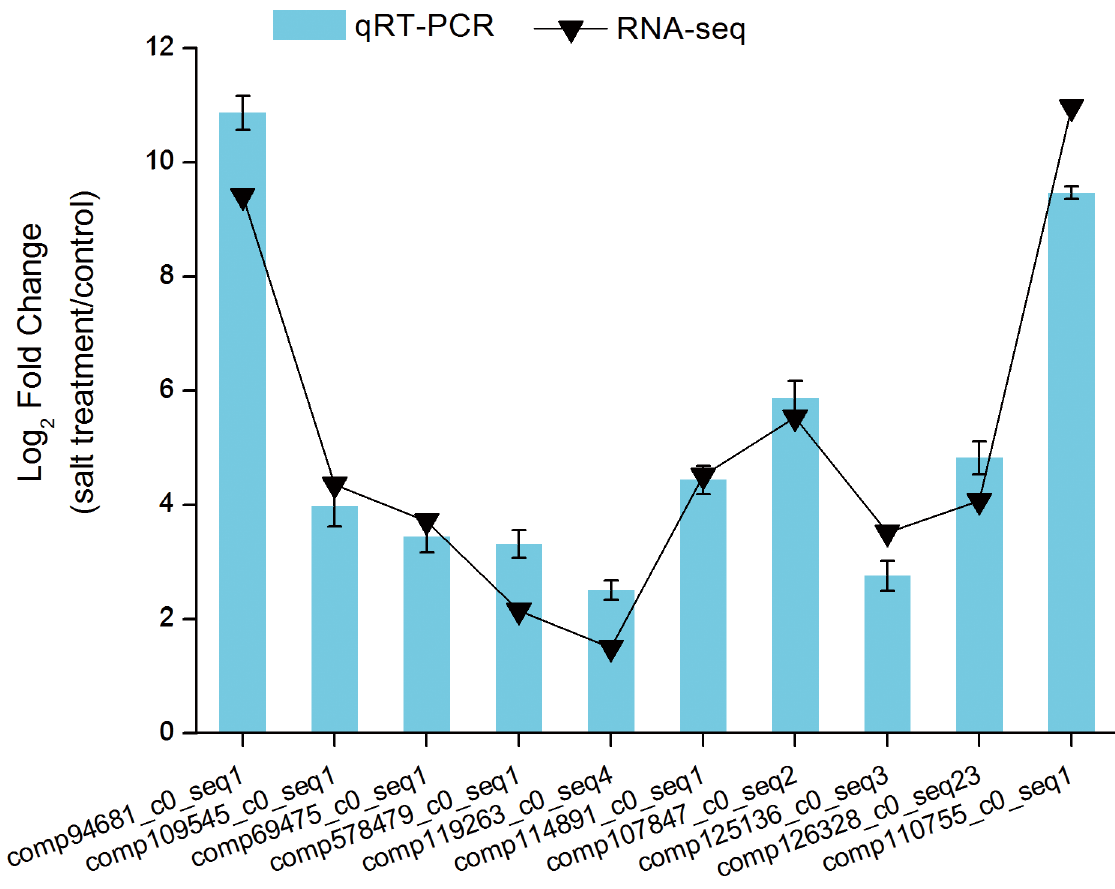
Fig 7. The relative expression levels of ten DETs between RNA- seq and qRT-PCR in chrysanthemum. The relative gene expression levels were determined by 2 − ΔΔ CT as expressed. Transcript levels were normalized to the expression level of UBC . Error bars SE from three independent